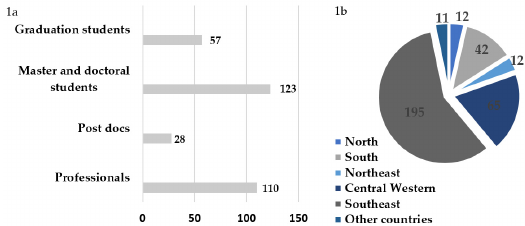
Figure 1. Participants of the 30th Brazilian Society for Virology Congress and 14th Mercosul Virology Meeting by category ( a ) and their respective institution locations in each country region ( b ). Table 1. Scientific programming schedule of the 30th Brazilian Society for Virology Congress and 14th Mercosul Virology